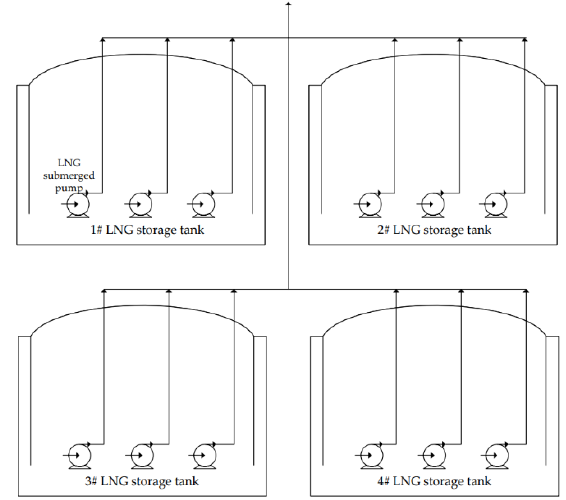
Figure 3. LNG submerged pump system process flow chart.